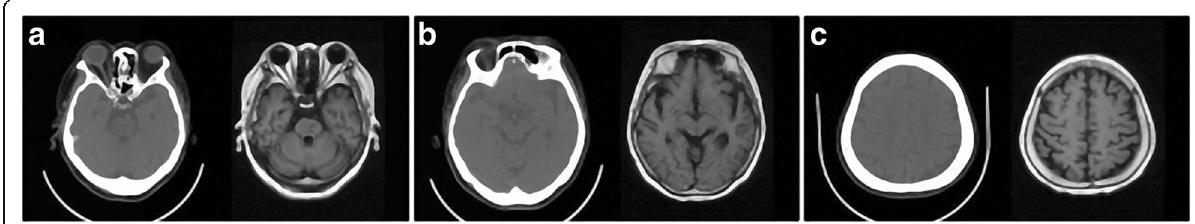
Fig. 4 The registered original images of patient 3. a , b , c are T1-MRI and CT images, respectively